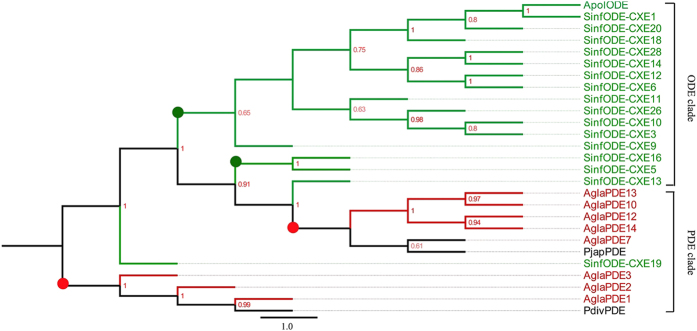
Neighbor-joining tree of candidate pheromone-degrading enzymes (PDEs).The NJ phylogenetic analysis of PDEs of A. glabripennis(AglaPDE, red) was performed with reference PDEs of Phyllopertha diversa (PdivPDE, dark), Popillia japonica (PjapPDE, dark), Sesamia inferens (SinfODE, Lepidoptera, green) and Antheraea polyphemus (ApolODE, green). The stability of the nodes was assessed by bootstrap analysis with 1,000 replications, and only bootstrap values ≥0.6 are shown at the corresponding nodes. The scale bar represents 1.0 substitution per site.